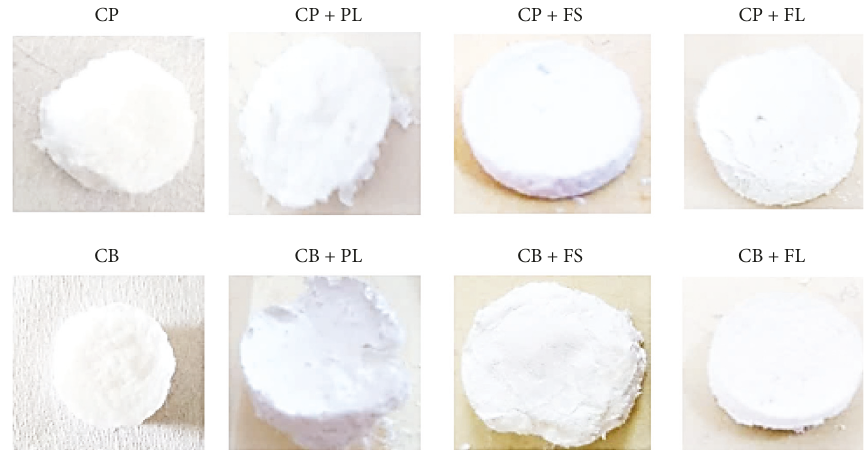
Figure 5: Macroscopic aspects of sponges. PL: P. lentiscus leaf extract; FL: C. officinalis leaf extract; FS: C. officinalis flower extract; CP: fish collagen; CB: bovine